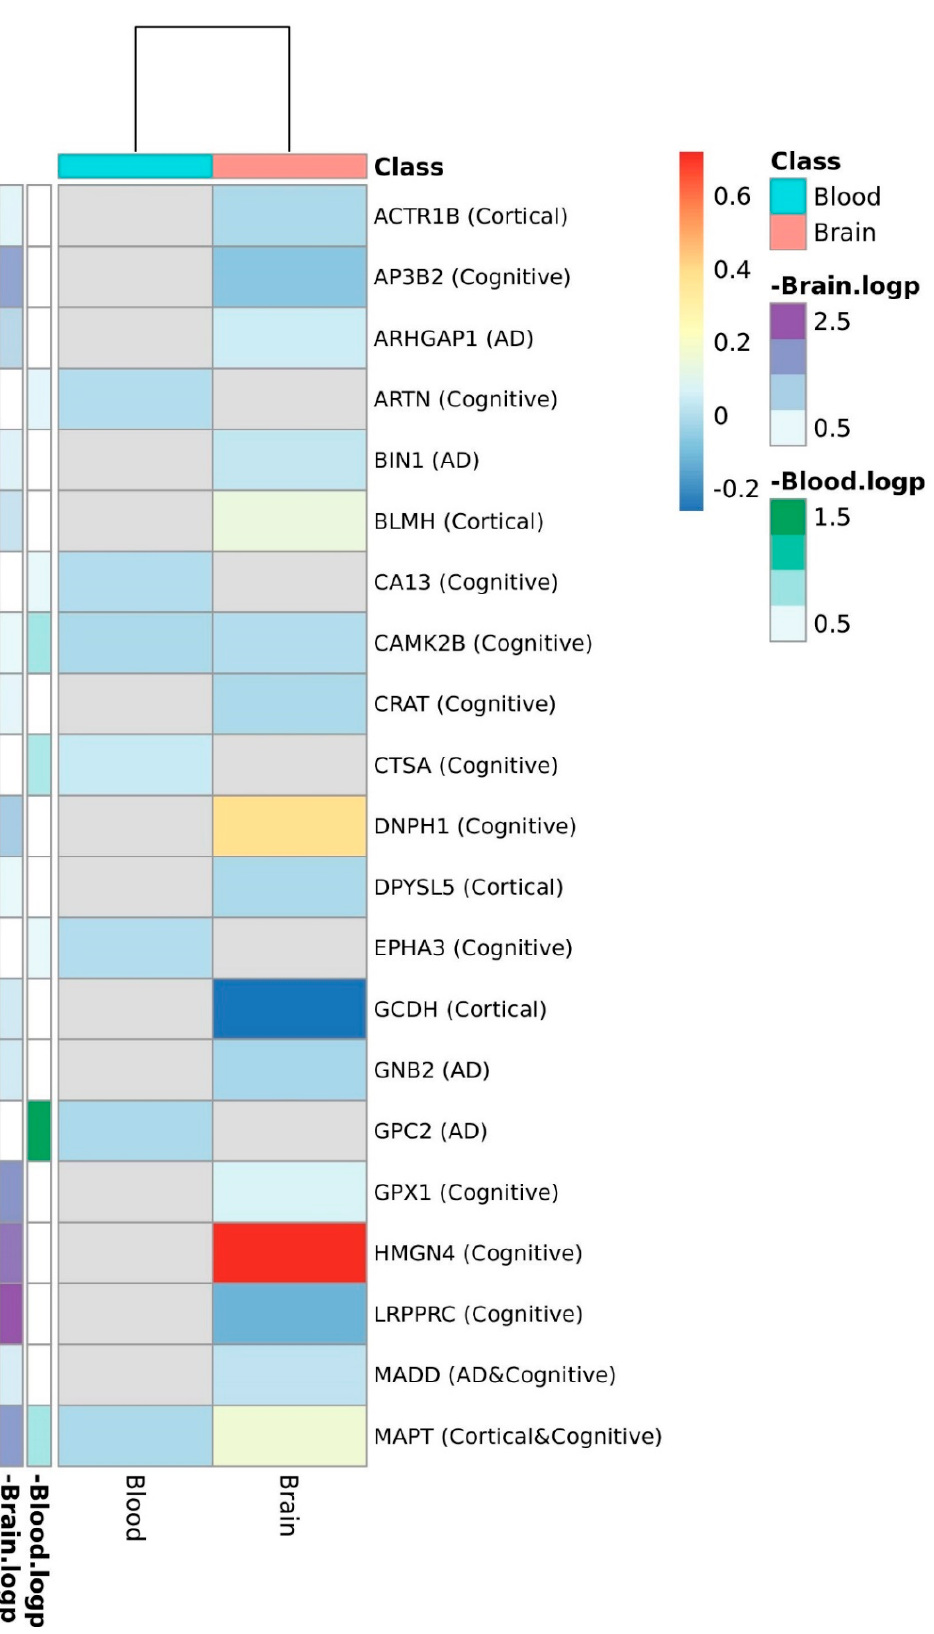
Figure 3. Heatmap plot of logFC expression values between AD cases and controls at the protein level. FC: Fold Change. Gene FCs were calculated as the average expression in the AD group relative to the average expression in the control group.